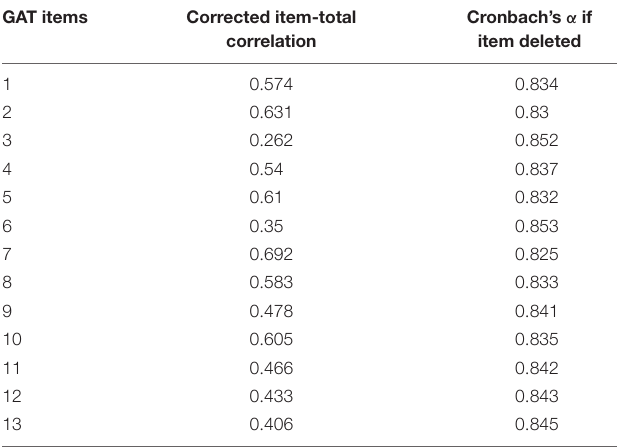
TABLE 6 | Intraclass correlation coefficient and percent concordance in rater A rankings for Grounding Assessment Tool (GAT) Scores ( n =